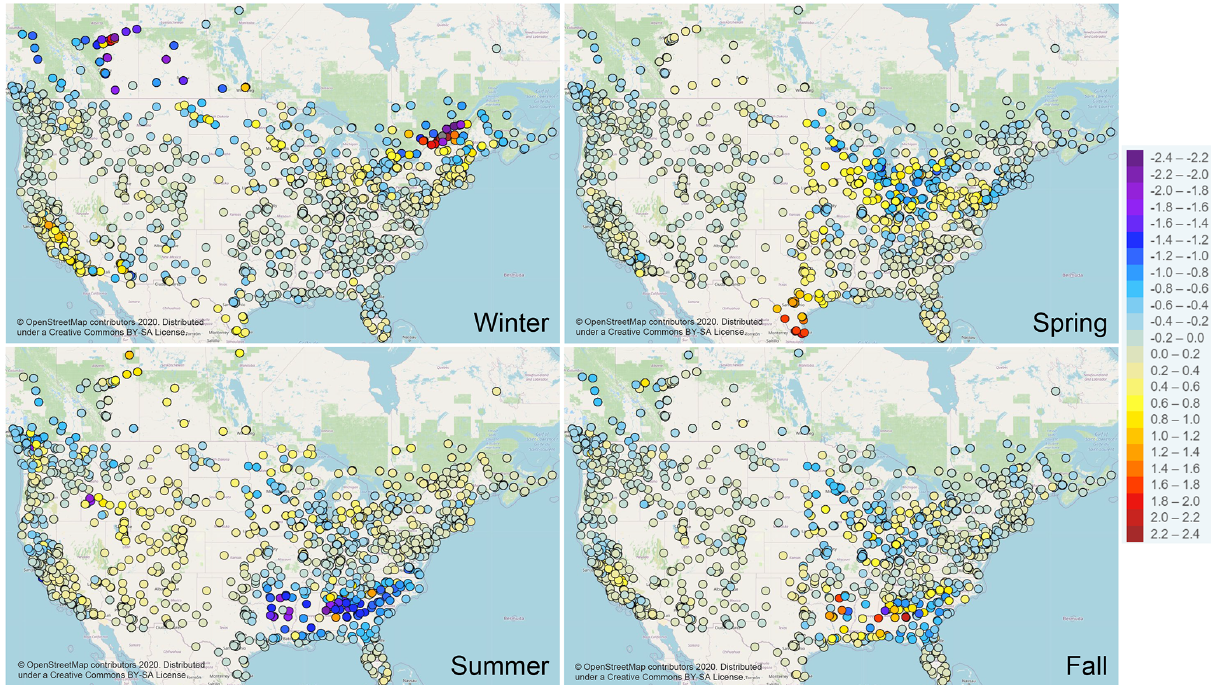
Figure 8. Seasonal average PM 2 . 5 absolute bias difference (µgm − 3 ) between the CMAQ521 and CMAQ531_WRF38_M3Dry_BiDi simula- tions for all AQS and NAPS sites. Cool shading (negative values) indicate smaller bias in the CMAQ531_WRF38_M3Dry_BiDi simulation, warm colors (positive values) indicate smaller bias in the CMAQ521 simulation. Grey shading indicates values beyond the range of the